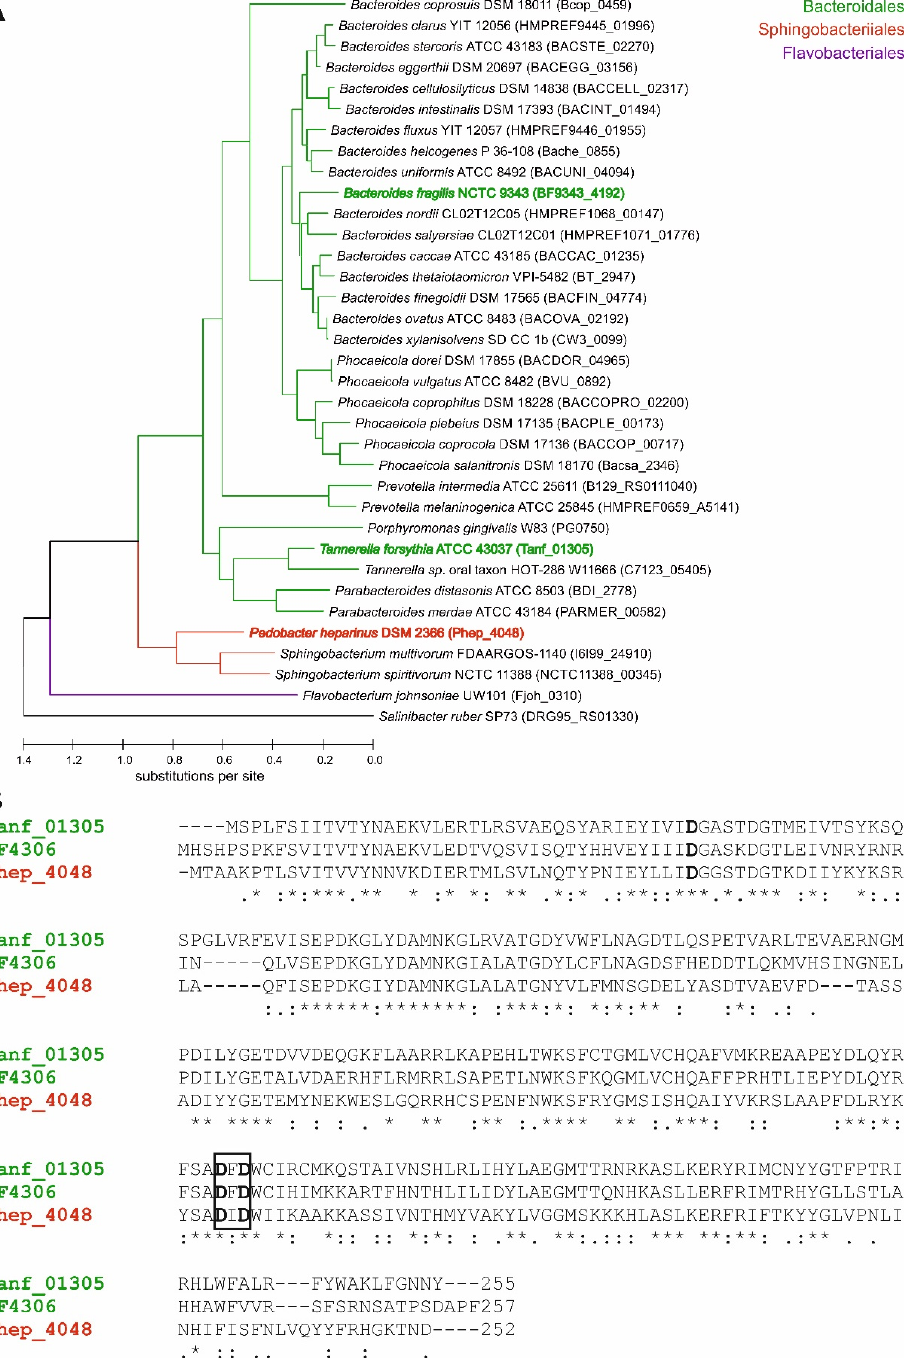
Figure 1. ( A ) Cladogram of the FucT orthologues in diverse species of the Bacteroidetes phylum. The maximum likelihood tree with the highest log likelihood ( − 9554.64) is shown, with initial trees generated using the Neighbor-Join and BioNJ methods applied to a JTT matrix-based model [25] of pairwise distances. The branch lengths of the tree indicate the number of substitutions per site (35 amino acid sequences comprising 359 positions). The tree was produced using MEGA X [23]. ( B ) Amino acid sequence alignment of T. forsythia Tanf_01305 (KKY62509.1), B. fragilis BF4306 (CAH09973.1), and P. heparinus Phep_4048 (ACU06239.1) illustrates the sequence similarity for compared sequences. The conserved DXD-motif typical of glycosyltransferases is indicated within a black box, and predicted metal binding sites are written in boldface. Amino acids identical in all three proteins are indicated with *. The alignment was calculated with the software Clustal Omega (www.ebi.ac.uk/Tools/msa/clustalo; accessed on 01 July 2021).